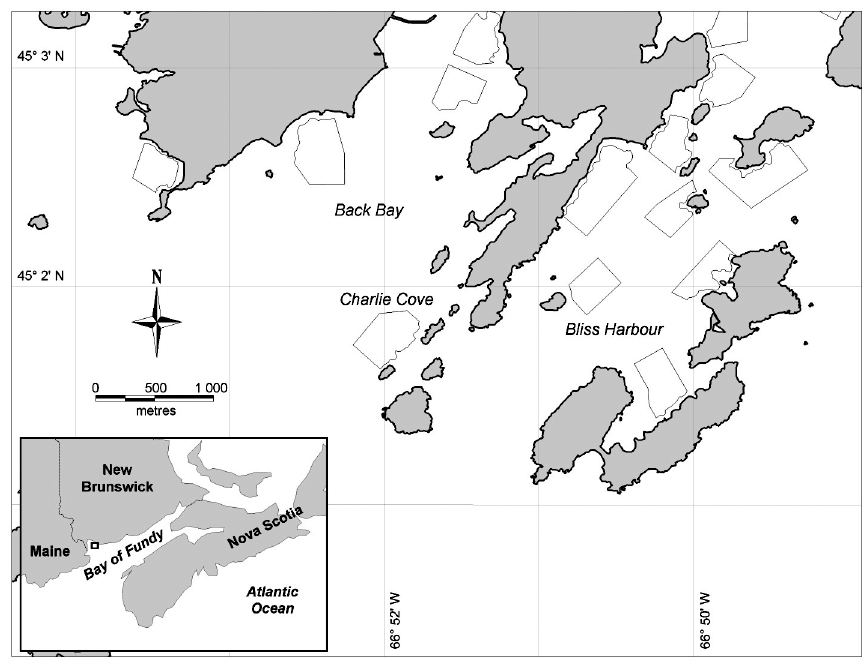
Fig. 1. Southwest New Brunswick, showing the study site at Charlie Cove. Aquaculture sites are outlined by gray